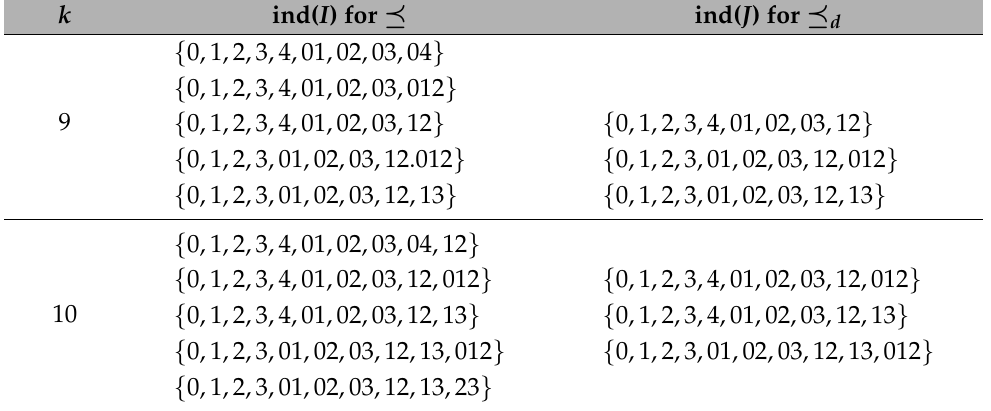
Table 2. Decreasing and strongly decreasing monomial sets for m =